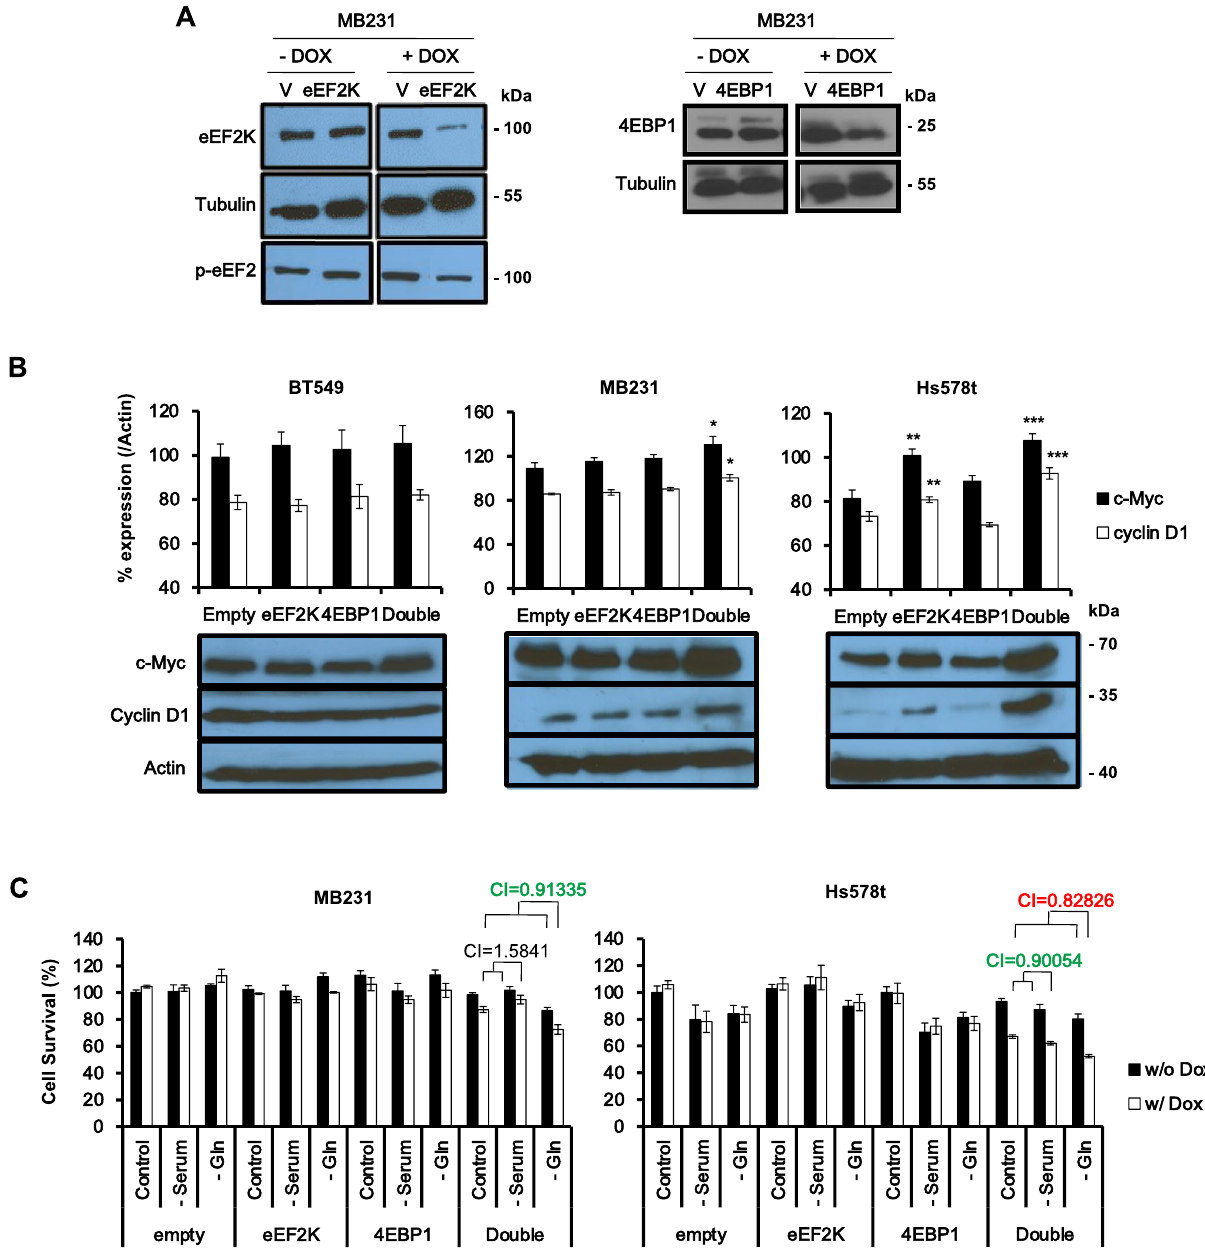
Figure 4. Establishment of tet-inducible knockdown of eEF2K and/or 4EBP1 in TNBC cell lines, and impact on cell growth. ( A ) Western blots showing the effect of tet-inducible eEF2K or 4EBP1 shRNAs on expression of the respective proteins in MDA-MB-231 cells. V denotes empty control vector. Uncropped images are shown in Supplementary Fig. S2. ( B ) Establishment of tet-inducible shRNA-mediated knockdown of eEF2K plus 4EBP1 in three different TNBC cell lines, and impact on CYCLIN D1 and c-MYC expression. *Denotes P < 0.05, ** P < 0.01, and *** P < 0.001 versus empty control vector by ANOVA; n = 4. ( C ) Cell survival determined by MTT assays in tet-inducible eEF2K - and/or 4EBP1 -depleted MDA-MB-231 and HS578t cells under normal or nutrient deprivation conditions (lacking serum or Gln). CIs was calculated by Compusyn software; synergy (CI < 0.85; red), additive (0.85 < CI < 1.1; green), and antagonistic (CI > 1.1;